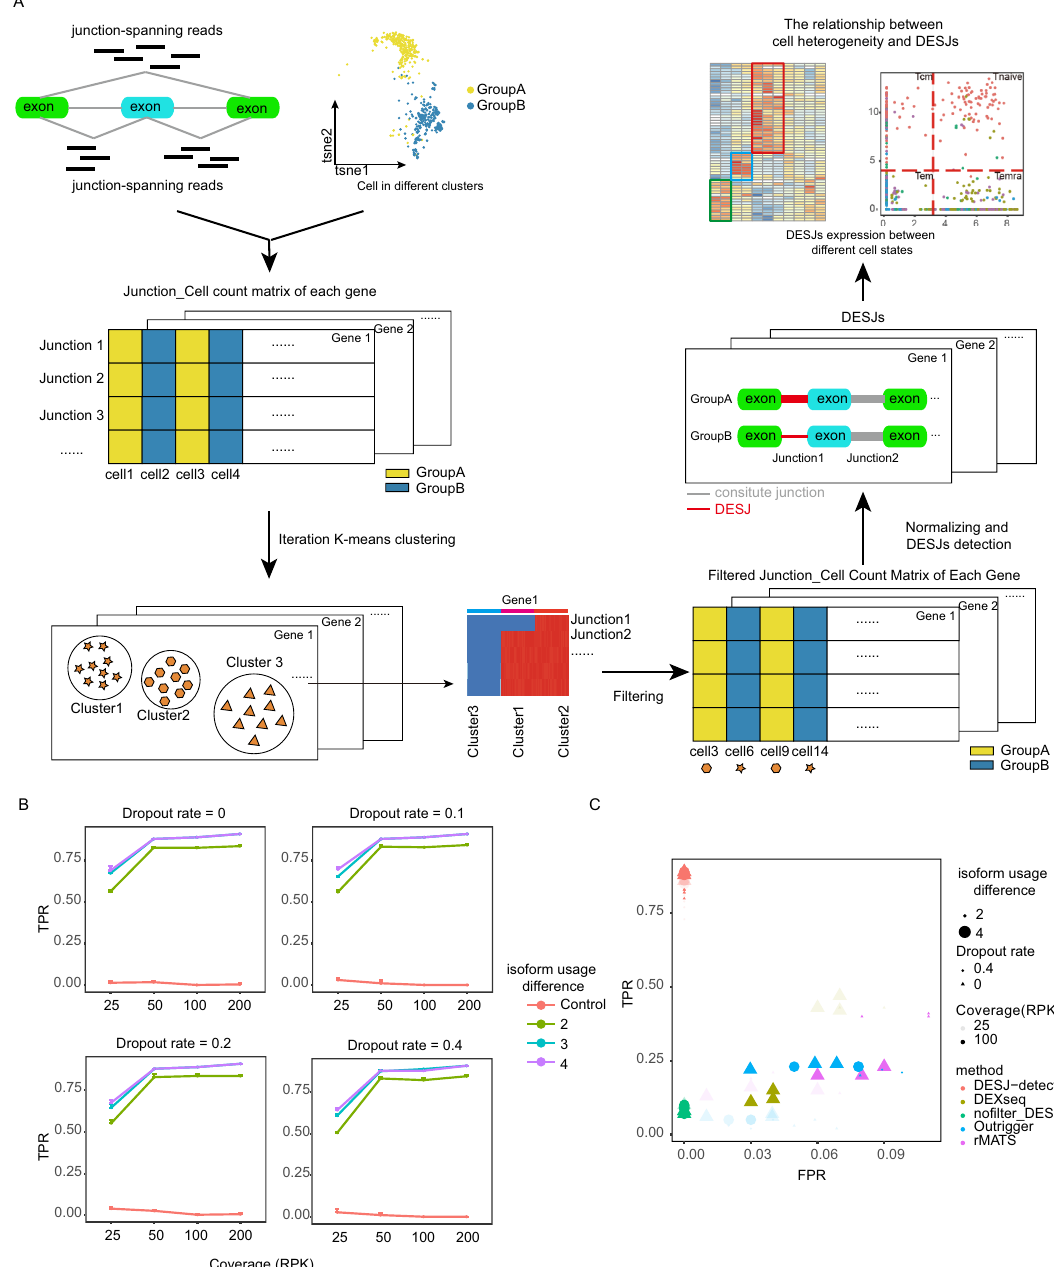
Figure 1. An overview of DESJ-detection. ( A ) DESJ-detection applies iterative k-means and gene-level normalization to filter cells and weaken the interference of gene expression. It provides a specific DESJ for each cell group. ( B ) A point plot demonstrating the TPR (true positive ratio) of DESJ-detection under different coverages, dropout rates, and isoform usage differences. ( C ) TPR, FPR (false positive ratio) and TP (true positive) are estimated by DESJ-detection and four other methods under different coverages, dropout rates, and isoform usage differences. Isoform usage difference refers to differences in the fraction of total expression of a gene represented by the expression of each of its